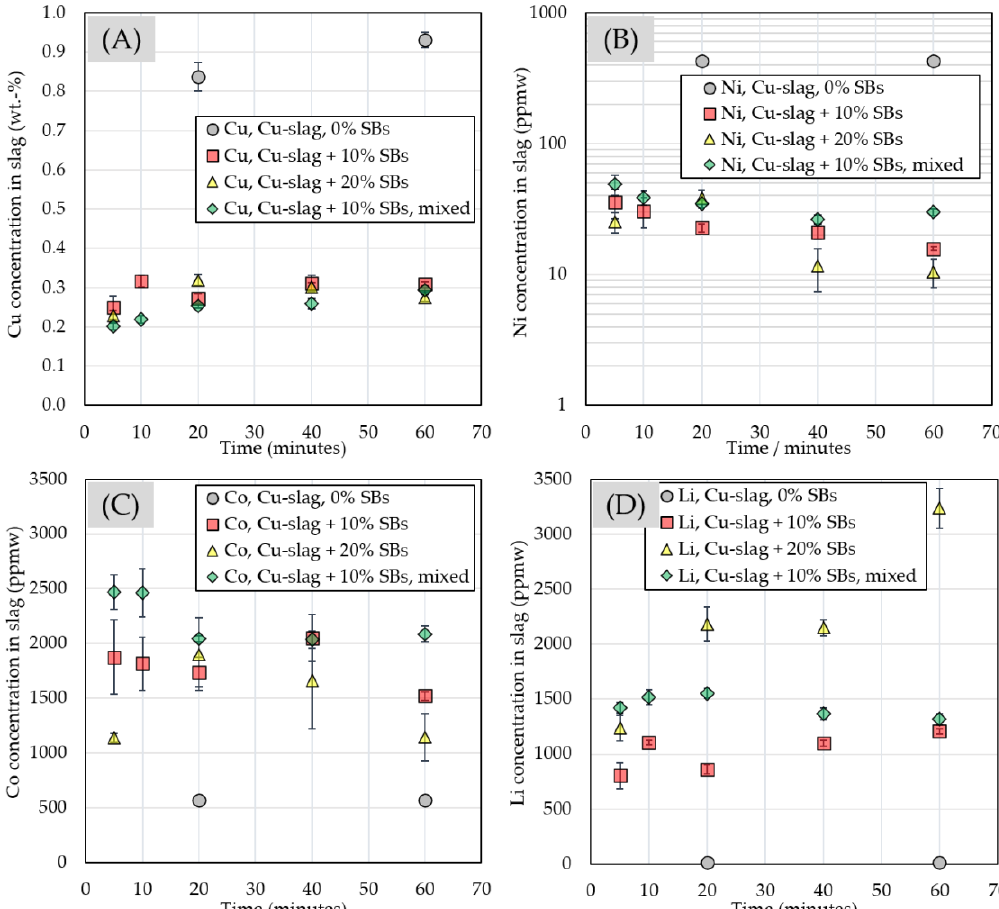
Figure 11. Concentration of trace elements Cu ( A ), Ni ( B ), Co ( C ), Li ( D ) in the slag as a function of contact time.